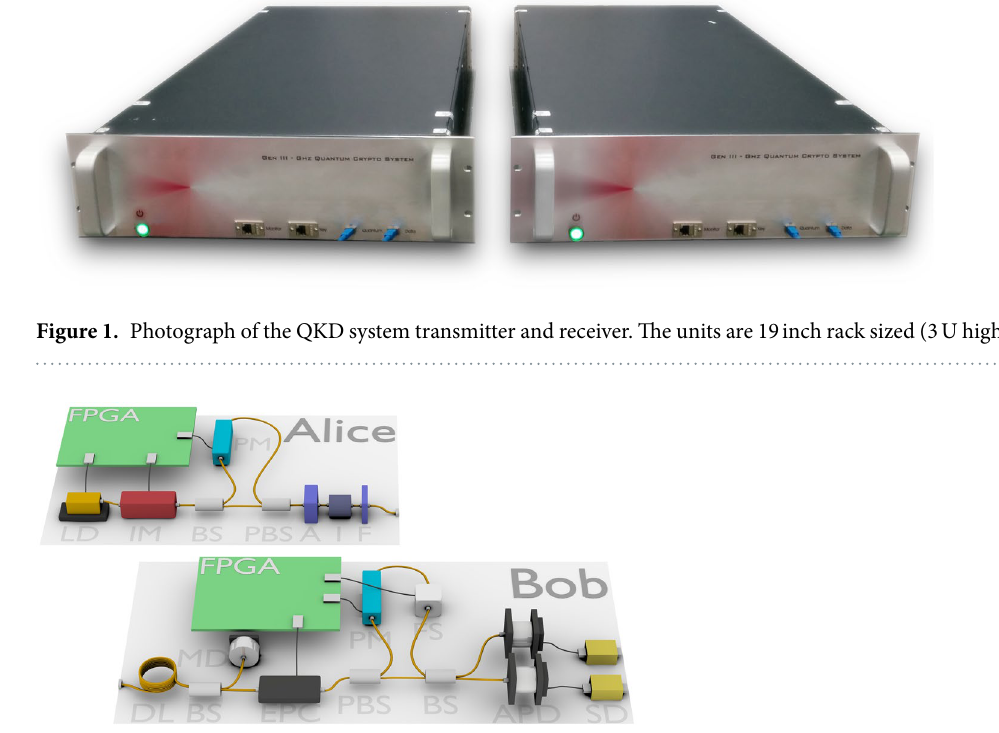
Figure 2. Schematic diagram of main components of the QKD system, showing the transmitter (Alice) and receiver (Bob). LD: Laser diode, IM: Intensity modulator, BS: Beam splitter, PBS: Polarising beam splitter, A: Variable optical attenuator, I: Optical isolator, F: Narrow band pass optical filter, DL: Delay line, MD: Monitoring detector, EPC: Electronic polarisation controller, FS: Fibre stretcher, APD: Avalanche photodiode detector, SD: self-differencing